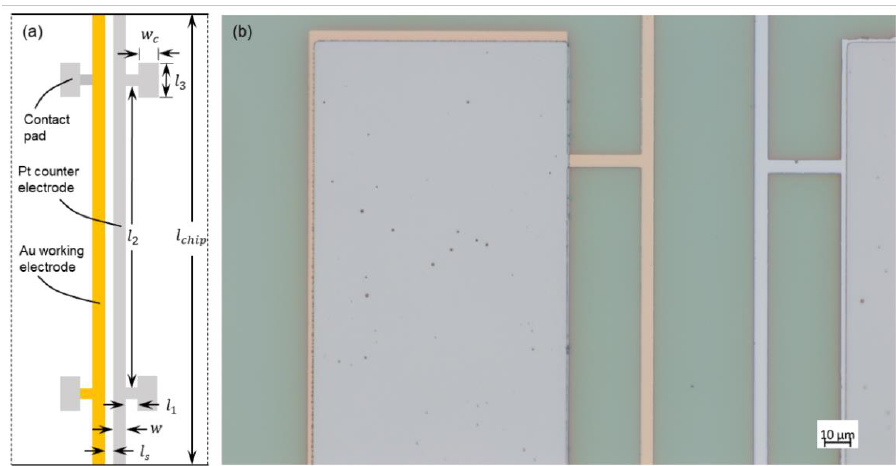
Figure 1. ( a ) Schematic (not to scale) of a chip bearing a Au LRSPP waveguide/working electrode, Pt counter electrode, and electrical contact pads on a multilayer dielectric substrate. The dimensions are: l 1 = 29 μm, l 2 = 2600 μm, l 3 = 250 μm, l chip = 3000 μm, w c = 100 μm, w = 5 μm, l s = 40 μm. ( b ) are: l 1 = 29 µ m, l 2 = 2600 µ m, l 3 = 250 µ m, l chip = 3000 µ m, w c = 100 µ m, w = 5 µ m, l s = 40 µ m. Microscope image of a fabricated chip. ( b ) Microscope image of a fabricated